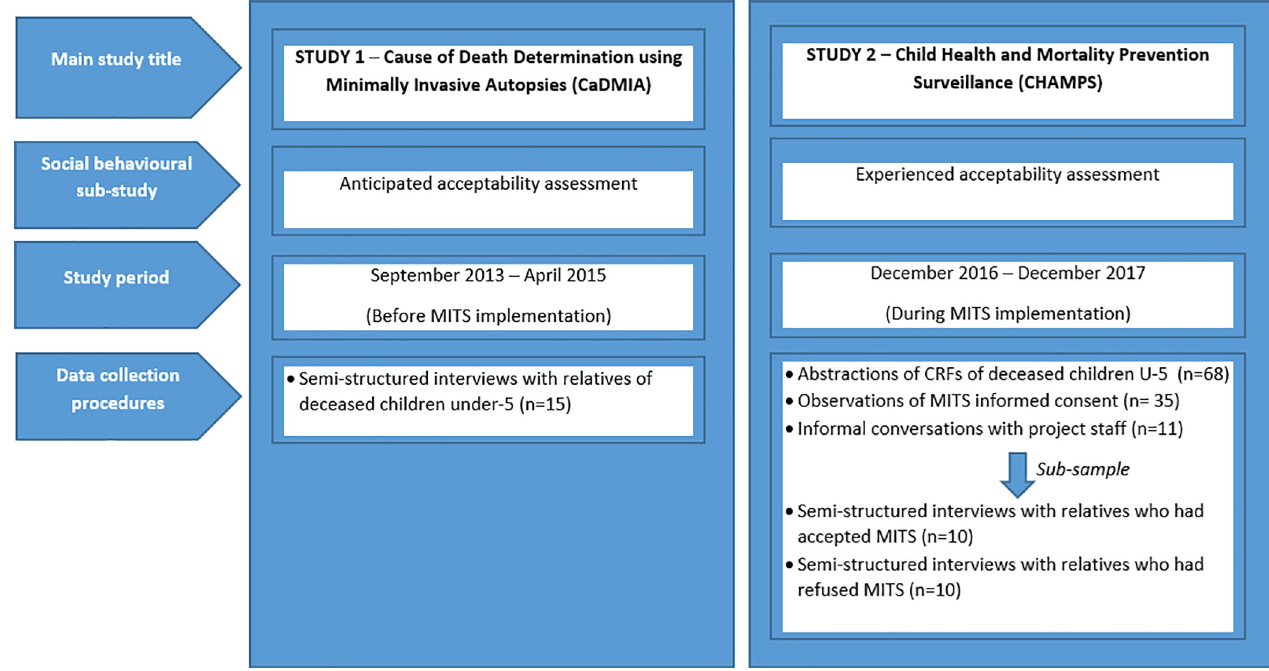
Fig 1. Schematic representation of the different study